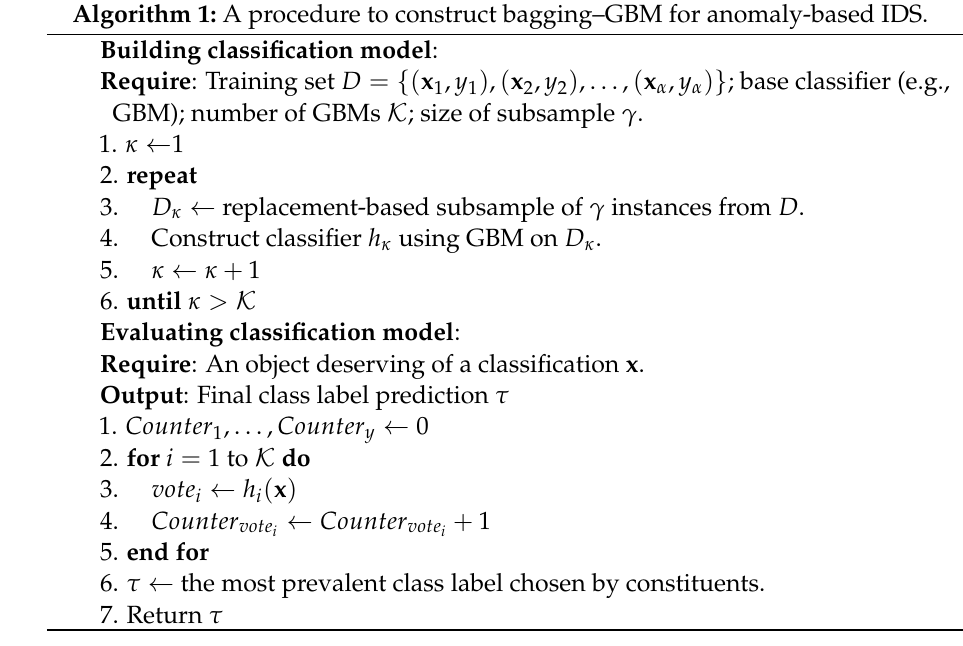
Algorithm 1: A procedure to construct bagging–GBM for anomaly-based